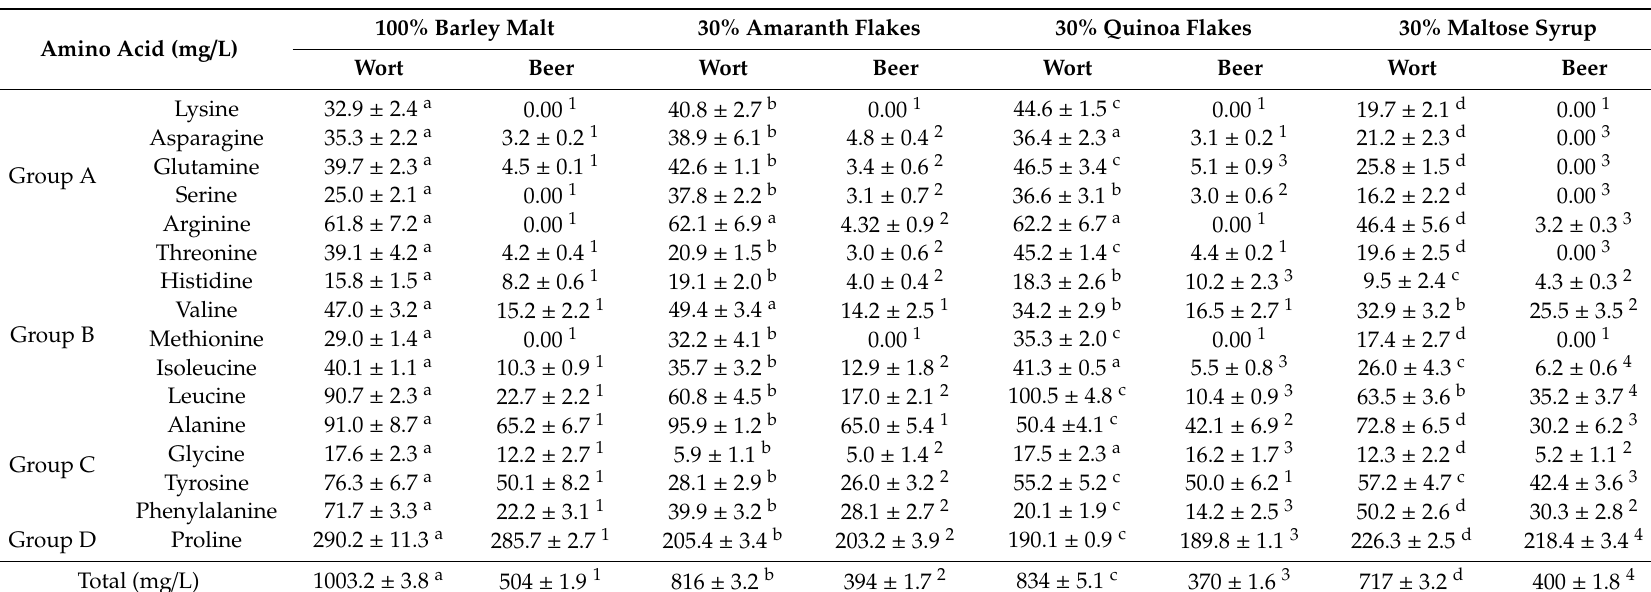
Table 3. The content of the amino acid in wort and beer produced with the addition of unmalted raw materials. Amino Acid (mg /